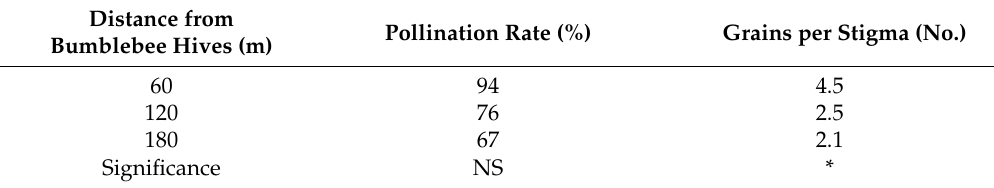
Table 6. Pollination rate and number of pollen grains per stigma of ‘Hass’ flowers at Kfar Giladi, 30 April 2019.